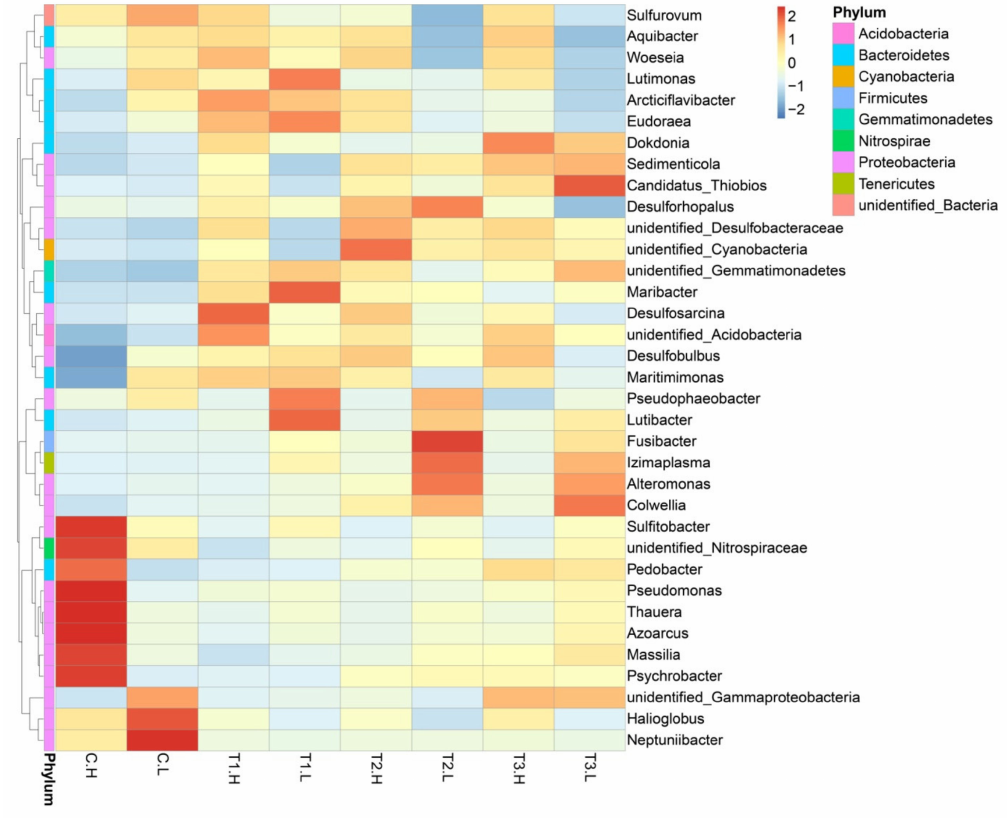
Figure 3. Relative abundance (%) of the top 30 microbial genera across eight groups revealed by 16S rRNA MiSeq sequencing. The sample numbers are shown in Figure 2. The unidentified genera were reconfirmed according to the species